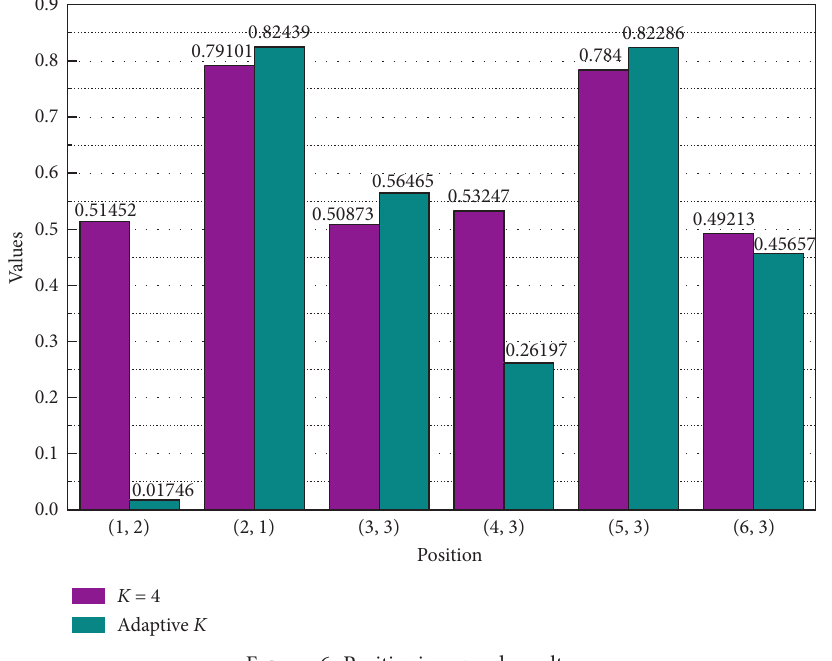
Figure 6: Positioning speed results.